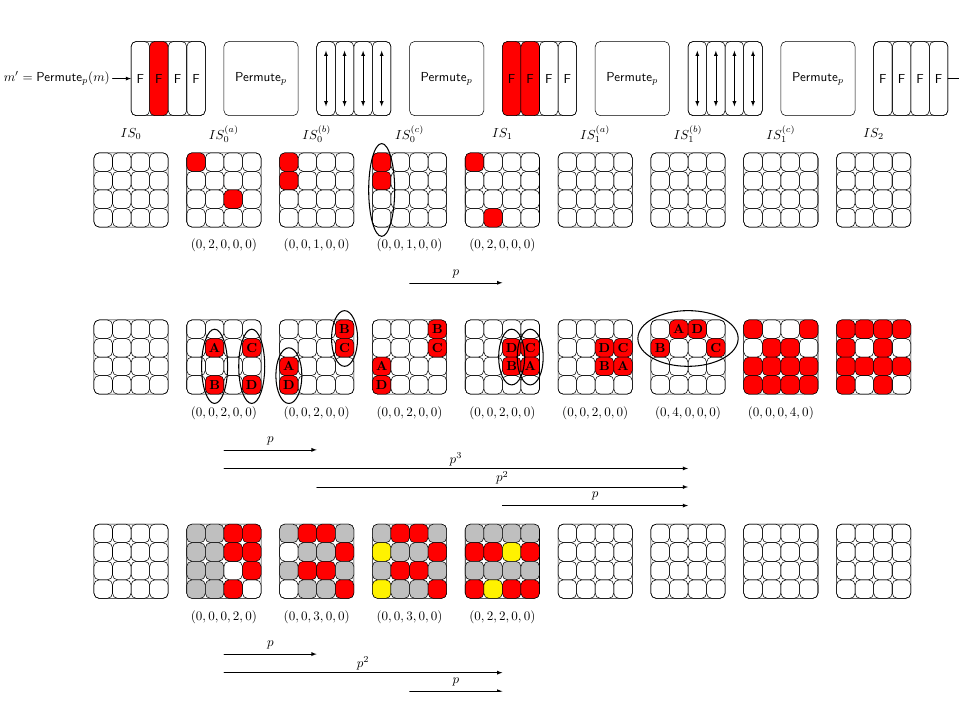
Figure 9: Differential trails of the form(2 → 2 → 2) in SE K , 3 , where Permute p is instantiated by the original cell permutation of Midori